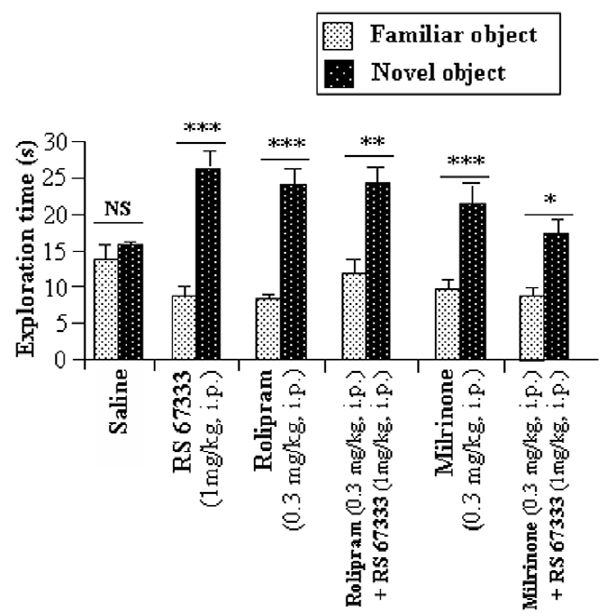
Figure 5. Object recognition task after a 4 h-delay in saline, rolipram- or milrinone- treated rats with or without RS 67333 co-treatment. Time of exploration of the familiar and novel objects during the testing phase of the object recognition memory task of saline (n=32), RS 67333 (n=32), rolipram (n=27), rolipram + RS 67333 (n=27), milrinone (n=27), or milrinone + RS 67333 (n=27)-treated rats. Rats were injected with the PDE inhibitor (0.3 mg/kg, i.p.) solution 45 minutes before the sample phase and with saline or RS 67333 (1 mg/kg, i.p.) solution 30 minutes before the sample phase. Object recognition was assayed after a 4 h-delay. Values are means in s 6 SEM. NS: non significant, (*) indicates a significant difference in comparison with saline treatment. (*, P , 0.05, **, P , 0.01, ***, P , 0.001, ANOVA followed by Fisher’s PLSD test).